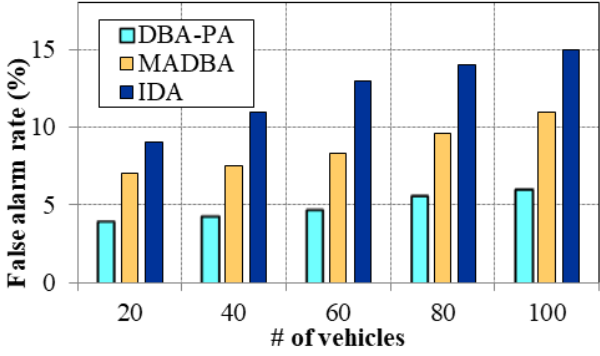
Figure 13. Number of Vehicles vs. False Alarm Rate.